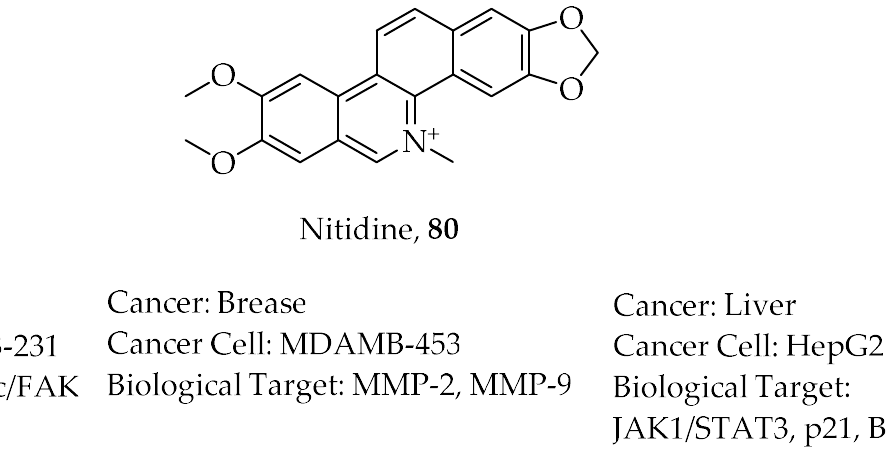
Figure 14. Chemical structure of Nitidine and a summary of its biological activity towards selected cancer targets.